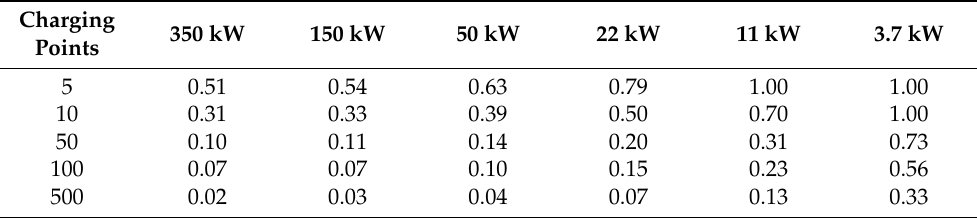
Table A7. Demand factors for the area type “Rural Region: Small-town Area, Village Area” and six charging powers.